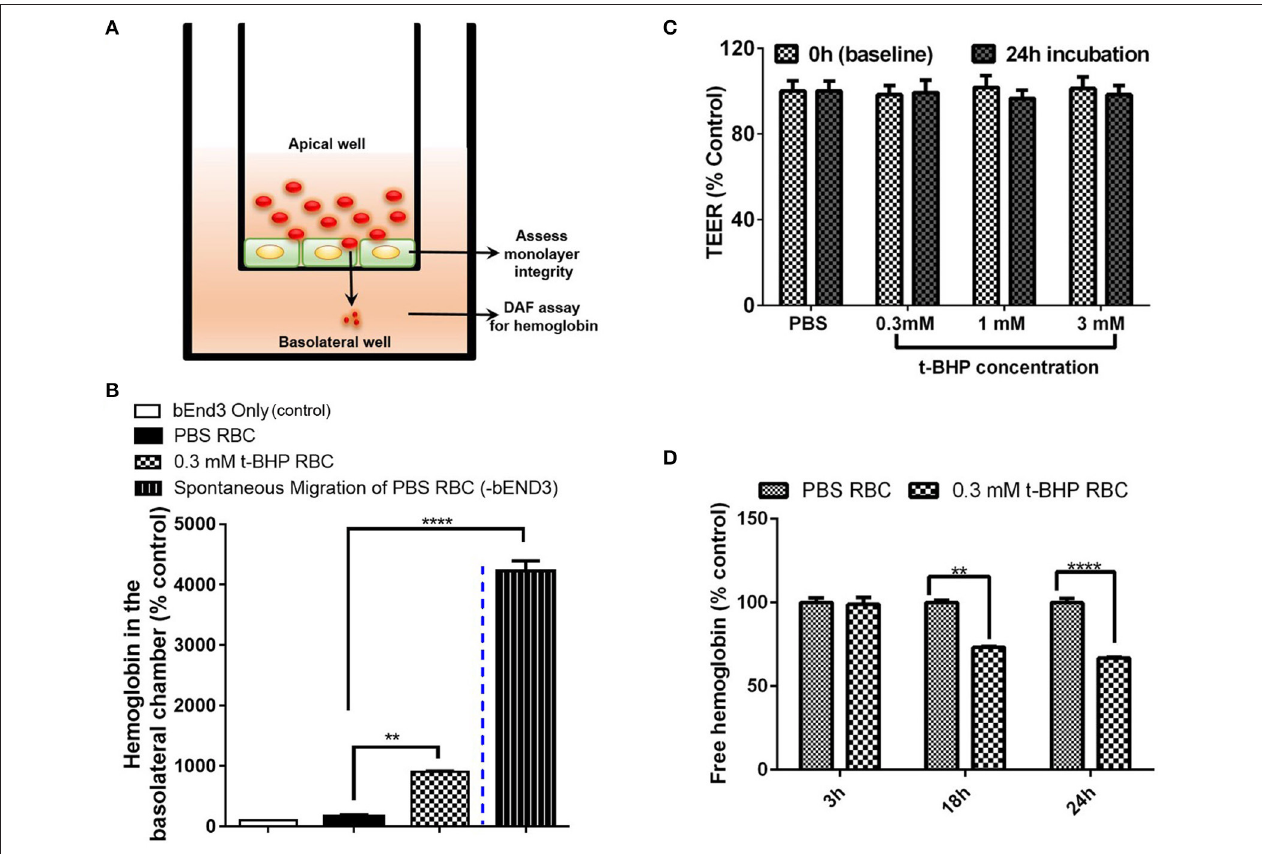
FIGURE 4 | Transmigration of hemoglobin across the bEND3 monolayer. Experimental set up to detect passage of hemoglobin across the bEND3 monolayer (A) . Significant increase in the passage of hemoglobin across the bEND3 monolayer incubated with t-BHP-treated RBC compared with PBS-RBC. Spontaneous migration reflects passage of hemoglobin from PBS-RBC across the 3 µ m pore size transwell in the absence of a bEND3 monolayer (B) . Passage of hemoglobin across the bEND3 monolayer grown on transwells incubated with t-BHP-RBC was not accompanied by a change in TEER; TEER measurements are presented as % of PBS-RBC values (C) . Free hemoglobin released by t-BHP-treated RBC is significantly lower compared with PBS-treated RBC. The bEND3 monolayer was grown on standard cell culture wells (D) . Data is presented as mean ± SEM of at least 3 independent experiments. ** p < 0.01, **** p <